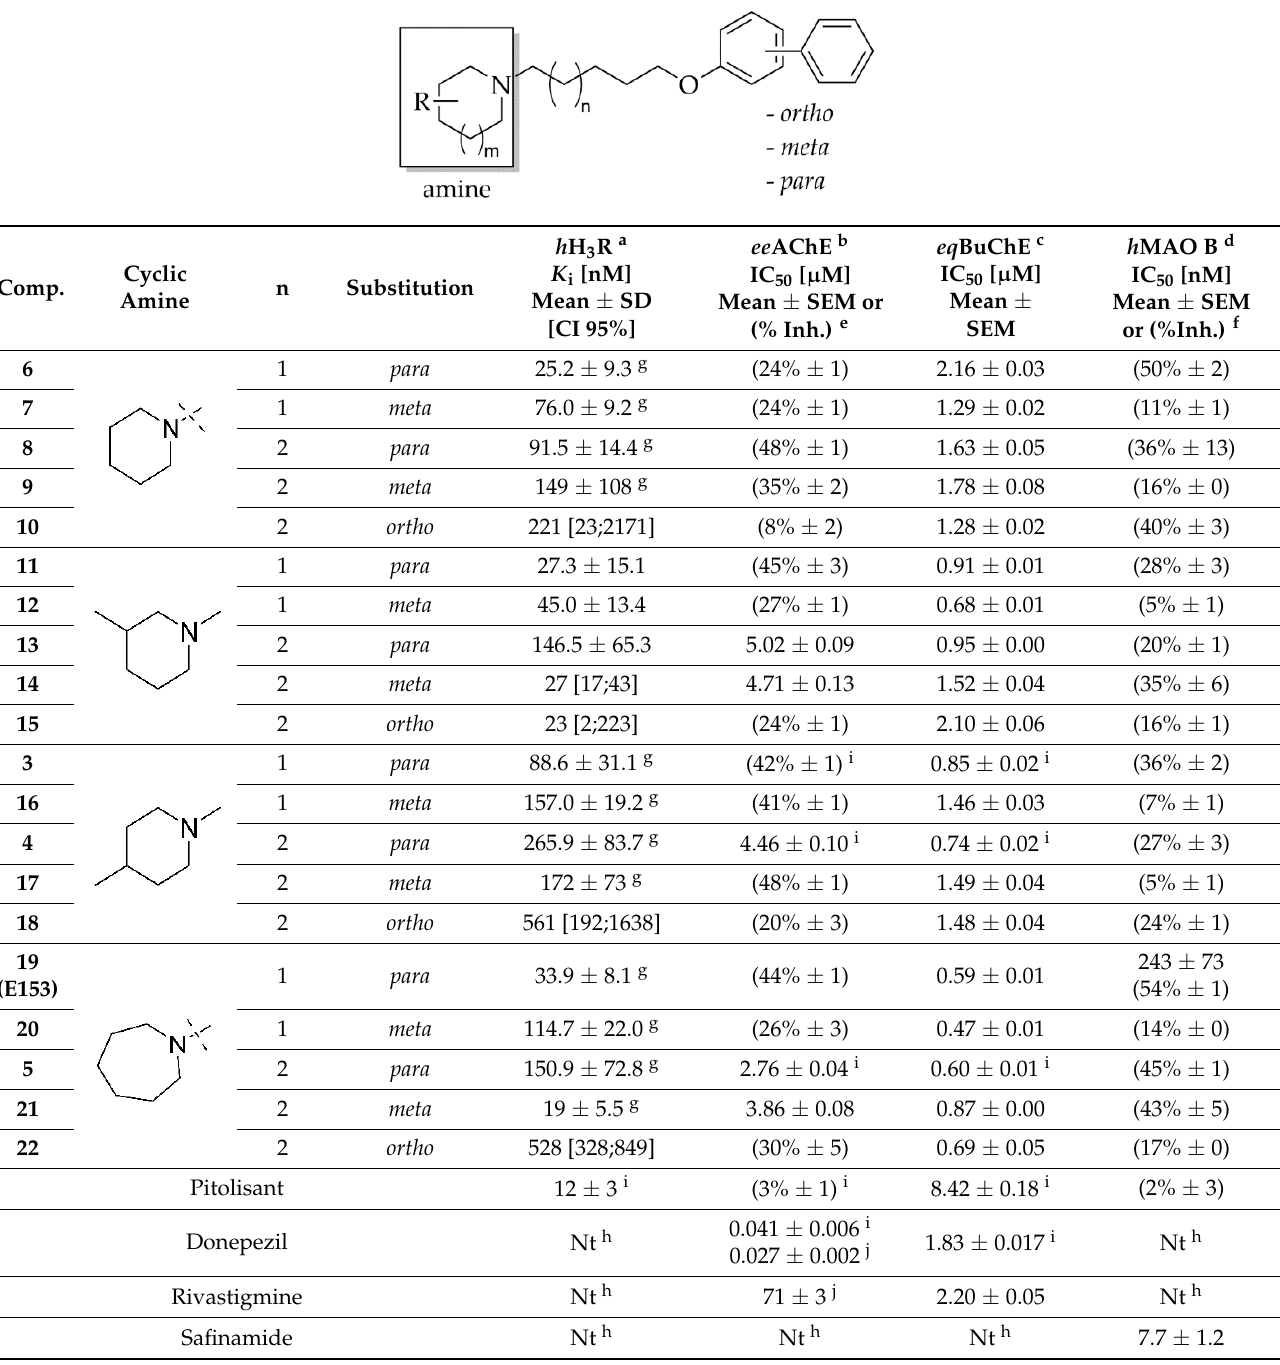
Table 1. Structures and biological activities of tested compounds.